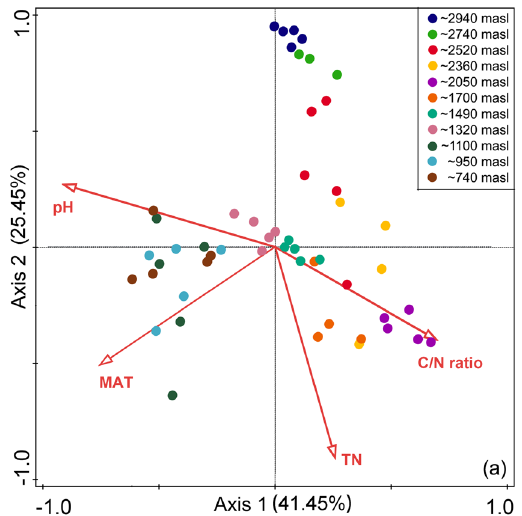
Figure 7. Canonical Correspondence Analysis ordination plot of soil nematode community structure based on 18S gene OTUs and a vector overlay of the environmental variables. Environmental variables were shown in arrows and only the significant ones were presented. Different colors of symbols denote different elevations.